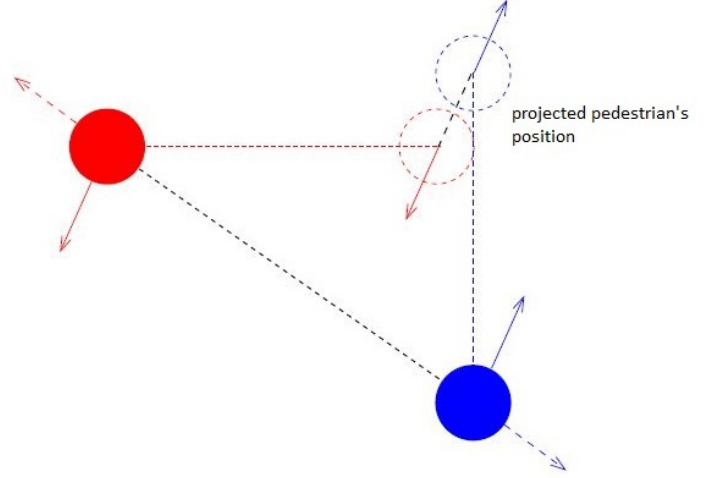
Figure 6. SFM with explicit collision prediction [36]: the position of the red and blue colored agents is projected at the time where the minimum distance between them is expected (dashed circles). For avoiding that situation, the agents will accelerate with the acceleration vectors denoted by the continuous arrows (drawn both at the present time positions and at the predicted positions). The dashed arrows (only drawn at the present time positions) are the acceleration vectors if the CS model is applied without prediction. Permission granted by Editorial EPL (Europhysics